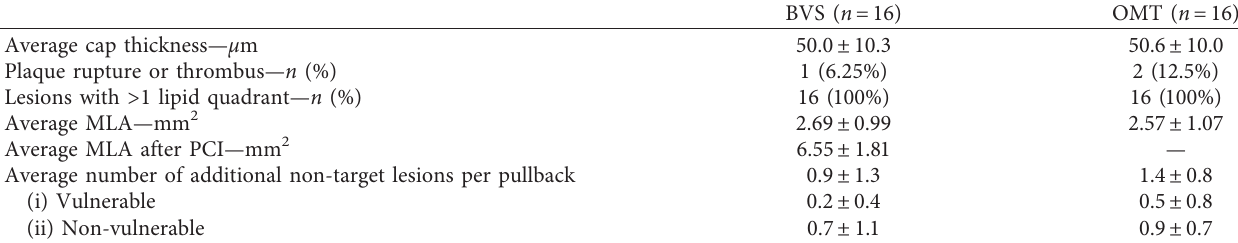
Table 3: Target lesion OCT